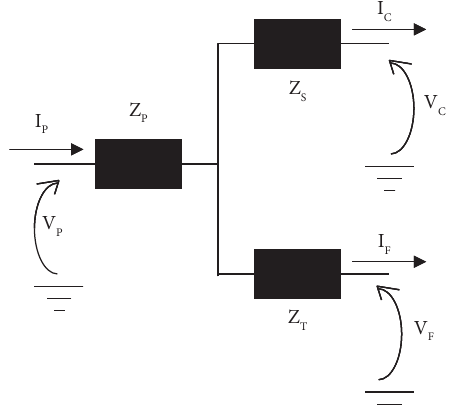
Figure 3: Traditional equivalent model for the 3-winding trans- former. Z P , Z S , and Z T are primary, secondary, and tertiary im- pedances (in pu).